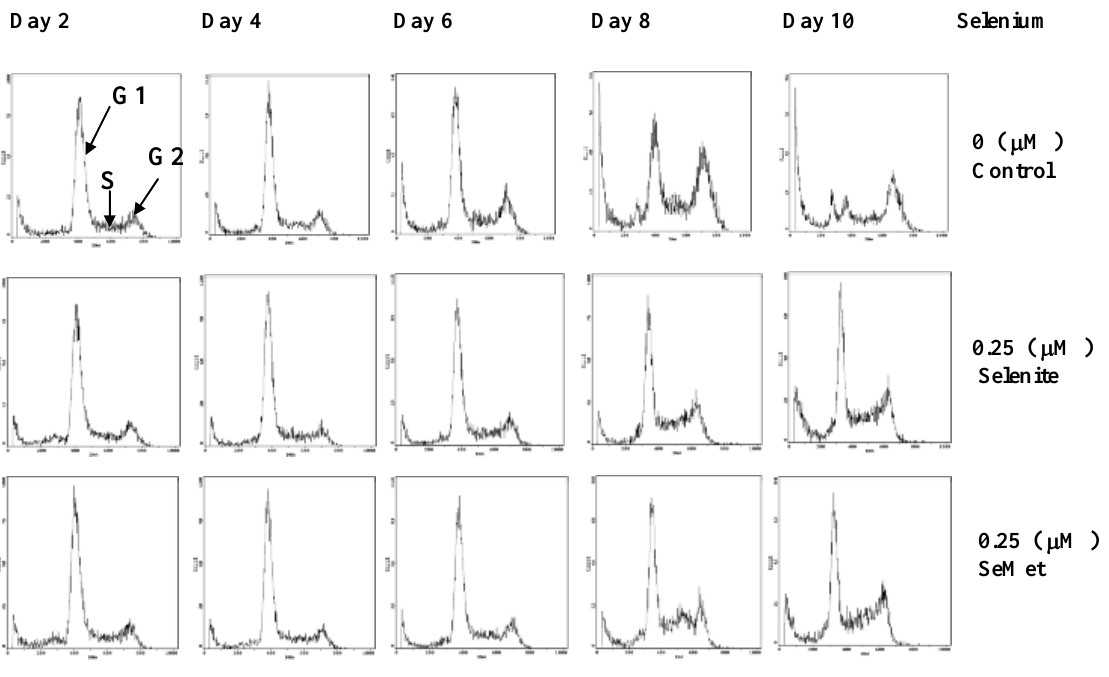
Figure 2. Flow cytometric profiles show cell cycle phase-distribution of the HL-60 cells in the absence of Se or in the presence of 0.25 μ mol/L selenite / SeMet (Adapted from